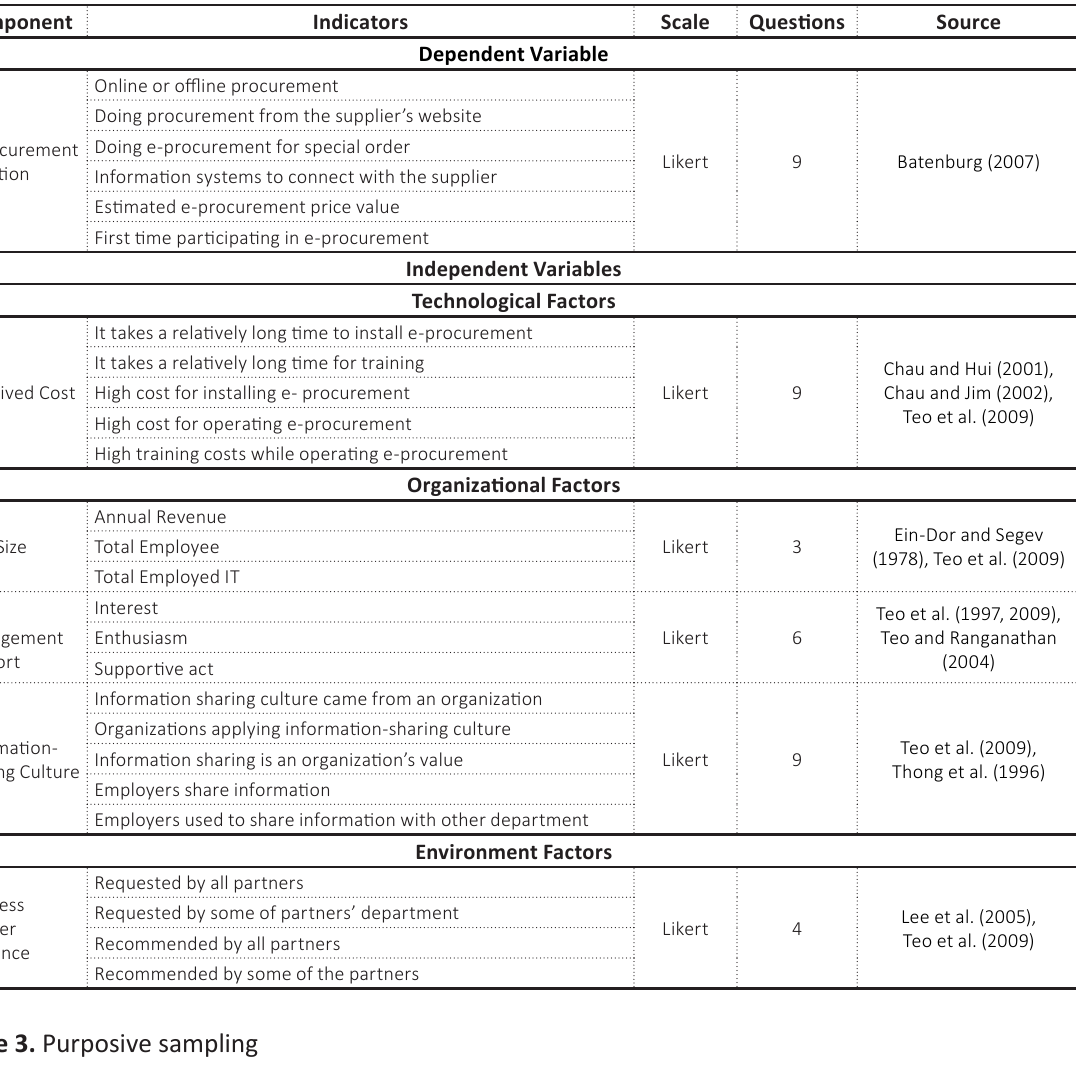
Table 2. Indicators of